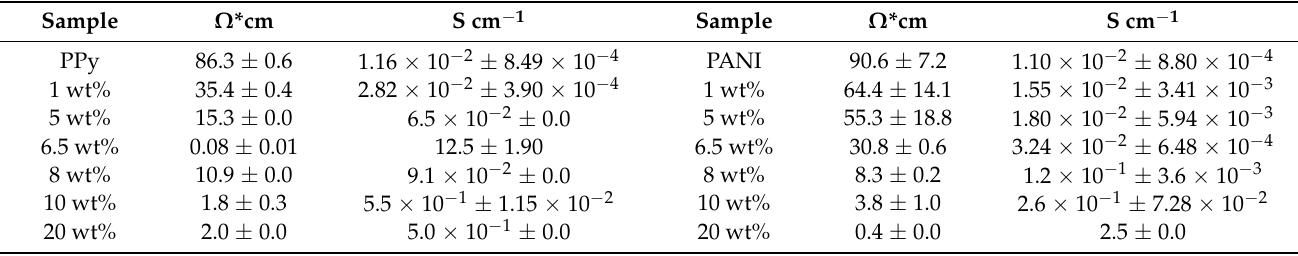
Table 3. Resistivity and electric conductivity of pure polymeric matrix (PPy or PANI) and nanocomposites with different MWCNTs amounts using a DC current of 1 mA, at room temperature. For these measurements, it was considered the surface area of each